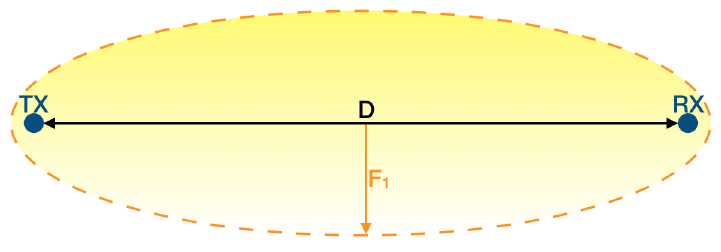
Figure 2. First Fresnel zone